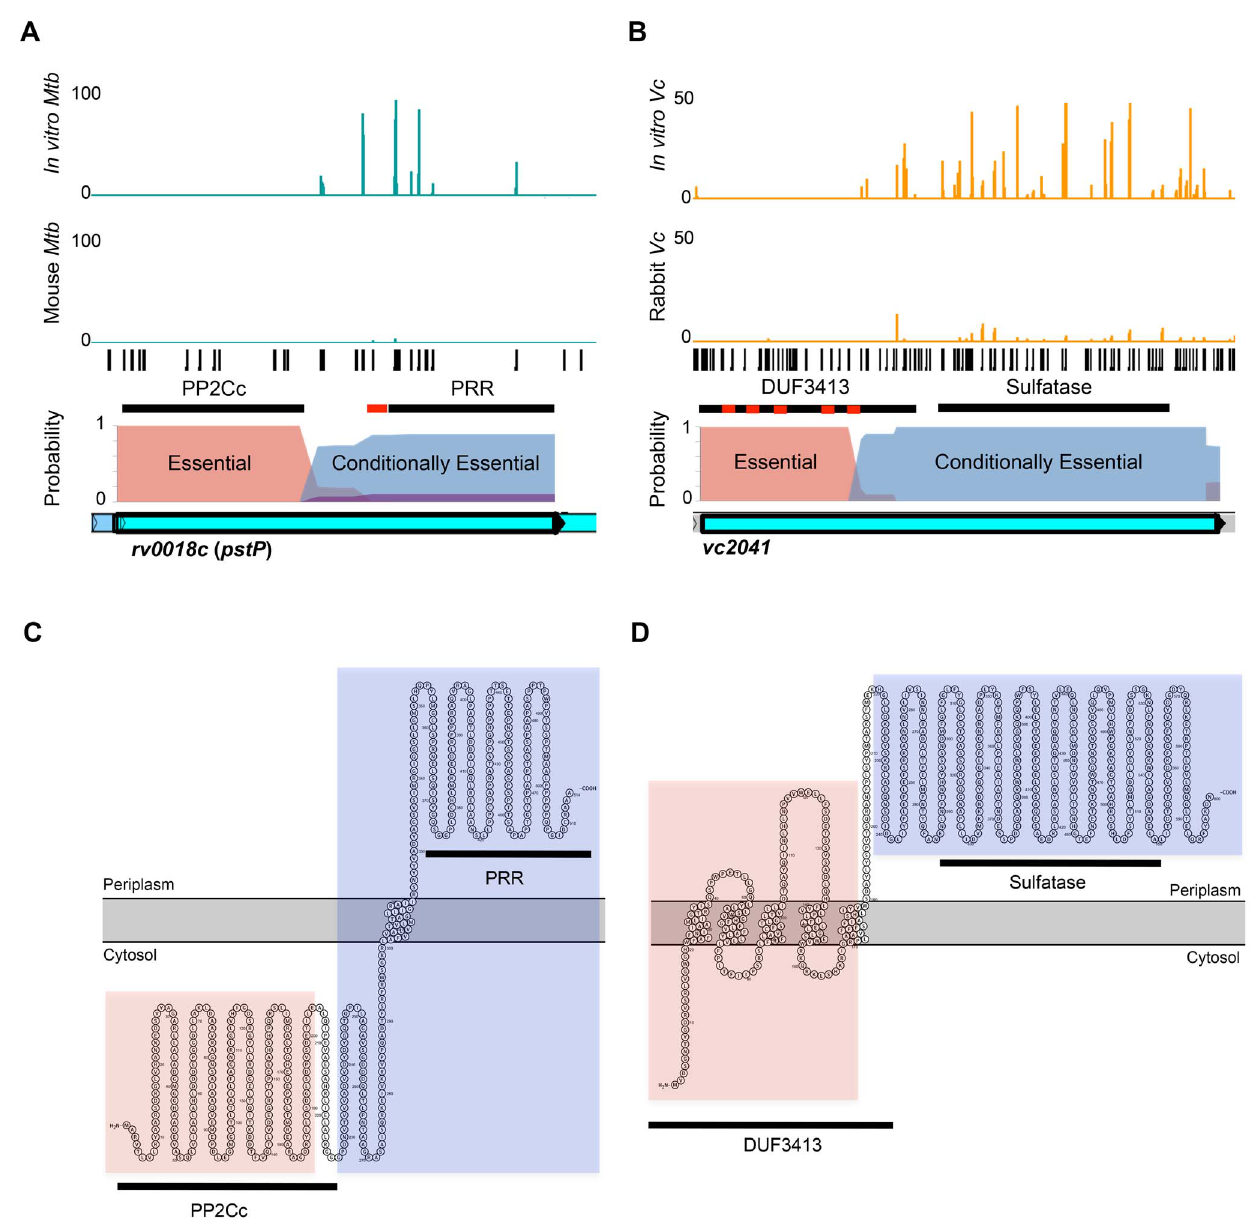
Figure 6. Con-ARTIST identifies conditionally essential regions required for host infection at sub-genic resolution. Con-ARTIST identified domain-encoding regions in M. tuberculosis rv0018c (A) and V. cholerae vc2041 (B) that exhibit conditional essentiality in vivo . Reads in each organism (blue and orange) from in vitro and in vivo grown transposon libraries were mapped to each potential insertion site (TA dinucleotides, black bars) in the genome. Protein domains predicted by Pfam (black lines) and transmembrane segments predicted by Phobius (red boxes) are shown. The Con-ARTIST probabilities for each insertion being conditionally essential (blue), essential for growth in vitro (red) or non-essential in vivo (purple) are graphed along the gene (no probabilities for conditional enrichment were detected). The cellular compartments of Rv0018c (C) and VC2041 (D) protein domains were predicted and overlaid with the predicted Pfam protein domains (black lines) using Protter [36]. Con-ARTIST-defined regions of essentiality (pink shaded region) and conditionally essentiality (blue shaded region) were also overlaid. rv0018c covers , 1.5 kb, while vc2041 is , 1.8 kb.